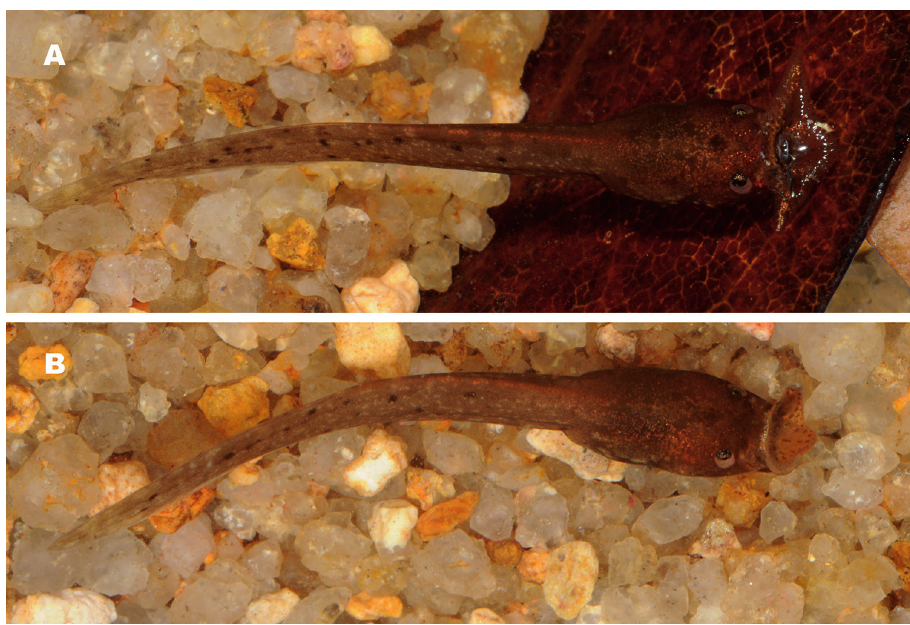
Figure 12. Coloration of Ophryophryne tadpoles in life: A Ophryophryne elfina sp. n. “(ZMMU A-5684, field number NAP-02673; Stage 25) from Chu Pan Fan Mt., 1900 m a.s.l. in Chu Yang Sin N.P., Dak Lak Prov., mouth funnel open B tadpole from the same locality and collection data (ZMMU A-5684, field number NAP-02673; Stage 25) with mouth funnel closed.. Photos by N.A. Poyarkov.